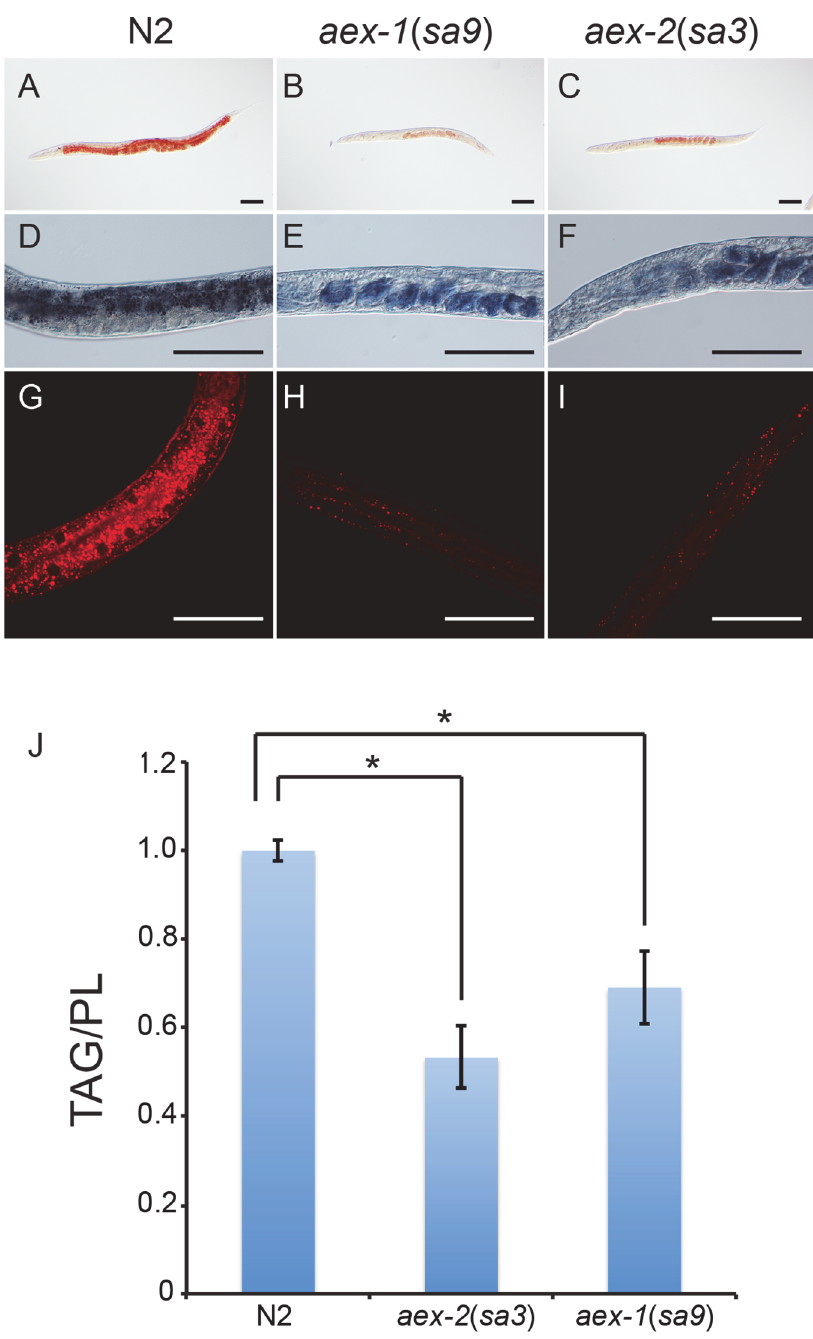
Fig 6. Mutations in aex-1 and aex-2 also cause a reduction in fat accumulation. A-C. Fixed, young adult hermaphrodite worms stained with Oil Red O. D-F. Micrographs showing part of the intestines of fixed, young adult hermaphrodite worms stained with Sudan Black. The staining in E and F is of eggs within the gonad. G-I. Fluorescence confocal micrographs of parts of young adult hermaphrodite worms fixed with isopropanol and stained with Nile Red. J. Graph showing the normalized ratios of total triglycerides to total phospholipids extracted from young adult hermaphrodite worms. Error bars represent 95% confidence intervals. * Indicates significant difference in the means determined by one-way ANOVA and Fischer's test for least significant difference ( σ =